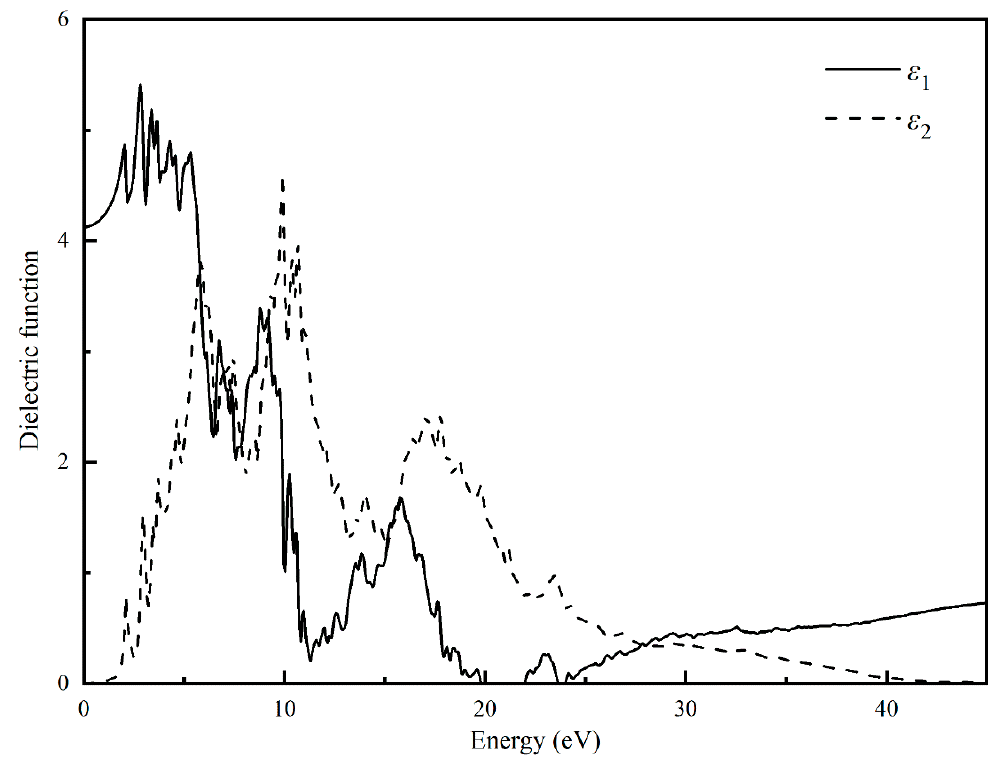
Figure 5. Calculated complex dielectric function of MgBi 2 O 6 .